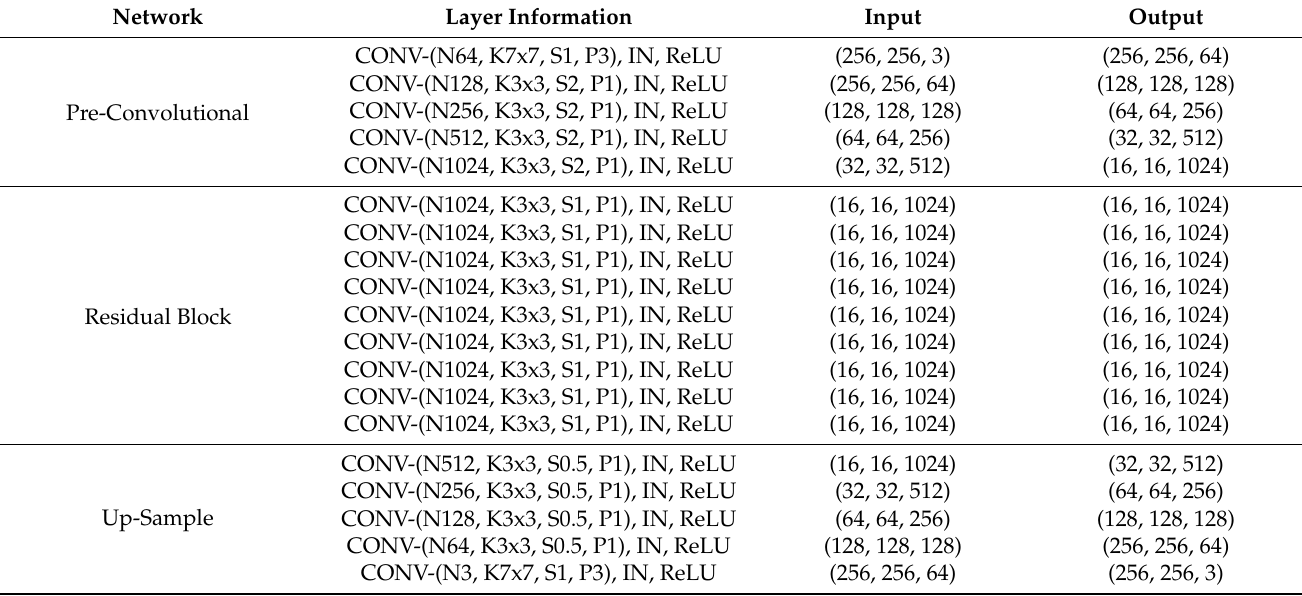
Table 2. The system architecture of the global